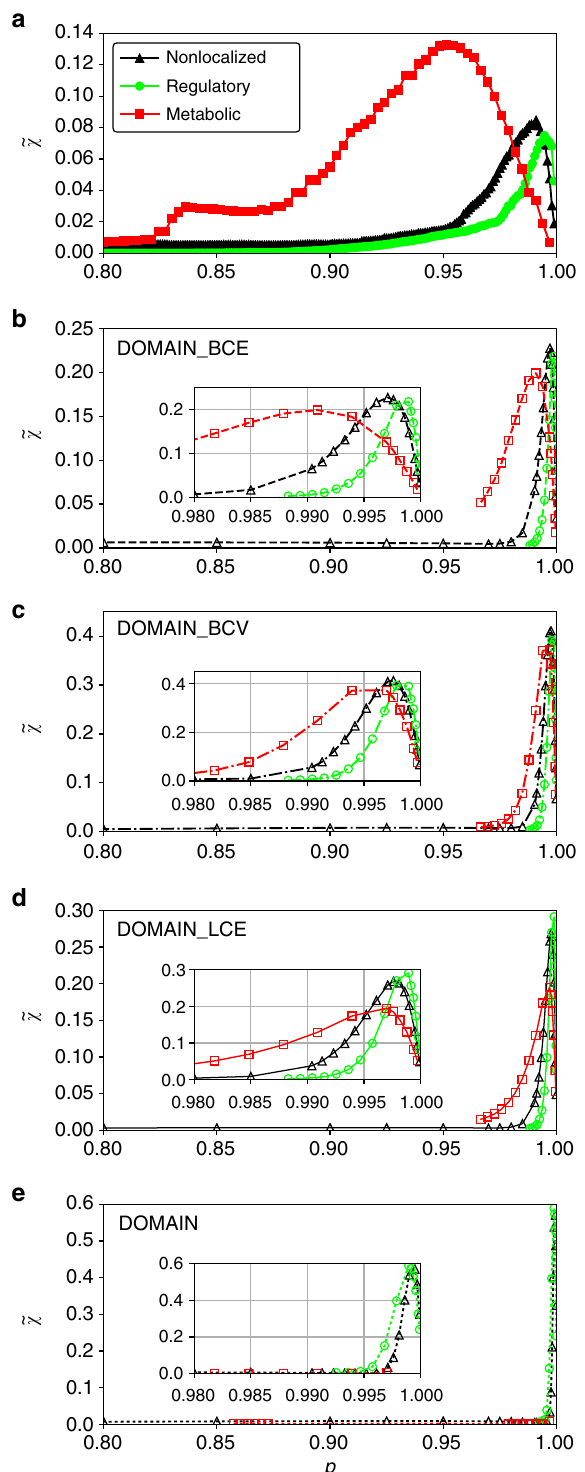
Fig. 4 Susceptibility of the integrative E. coli network and its randomized versions for distinct localized perturbations. In each panel, the average over 500 runs for an initial perturbation size, q = 1 − p , of the original network a and the four randomization schemes in decreasing stringency order b – e is shown. For each scheme 500 graph realizations have been considered. While non-localized perturbations are presented in black , perturbations initiated in gene regulatory domain and metabolic domain are given in green and in red ,